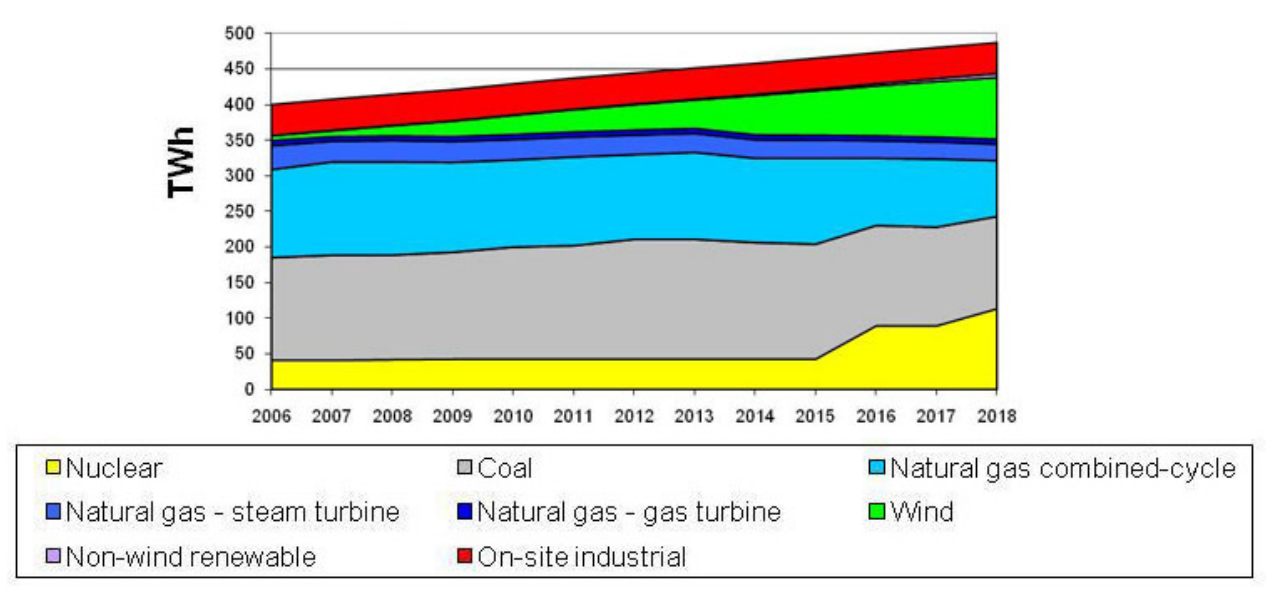
Fig. 8 . Projections of Texas electricity generation with a large increase in renewable energy-generated electricity (Webber et al.